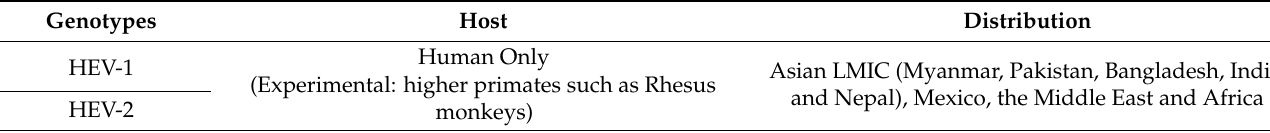
Table 1. Geographical distribution of HEV genotypes and their